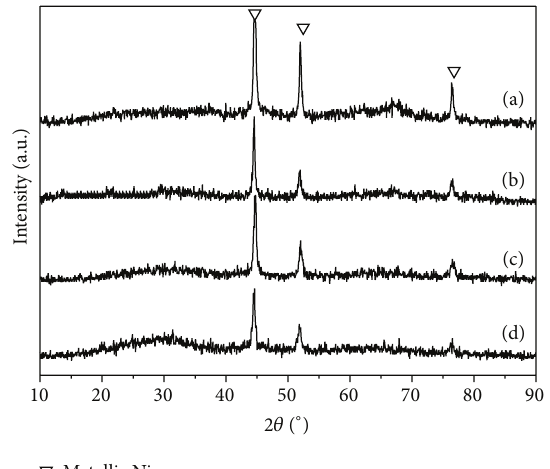
Figure 5: H 2 -TPD profiles of the studied catalysts. (a) 15Ni/100Al 2 O 3 , (b) 15Ni/10CaO90Al 2 O 3 , (c) 15Ni/20CaO80Al 2 O 3 , and (d) 15Ni/30CaO70Al 2 O 3